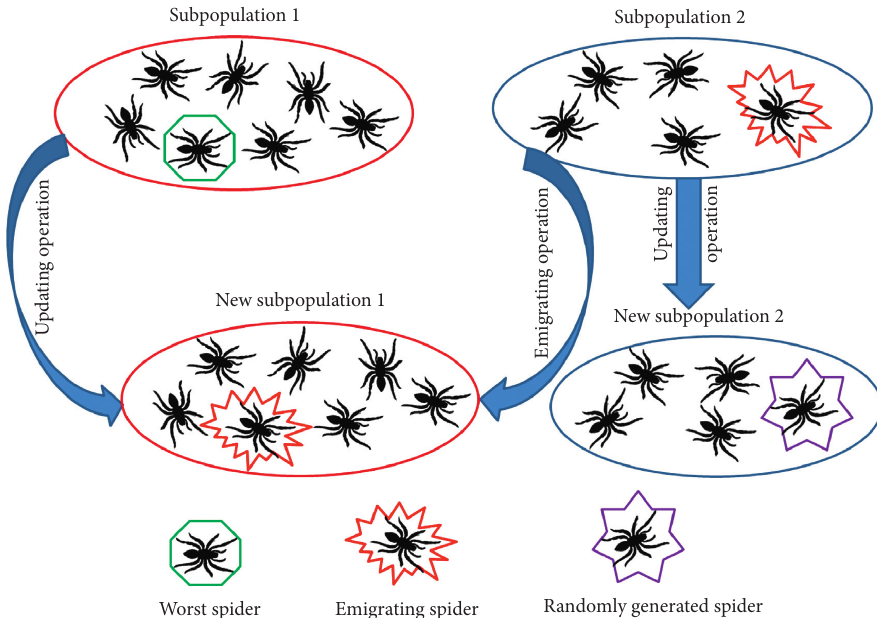
Figure 2: Subpopulation dynamically updating